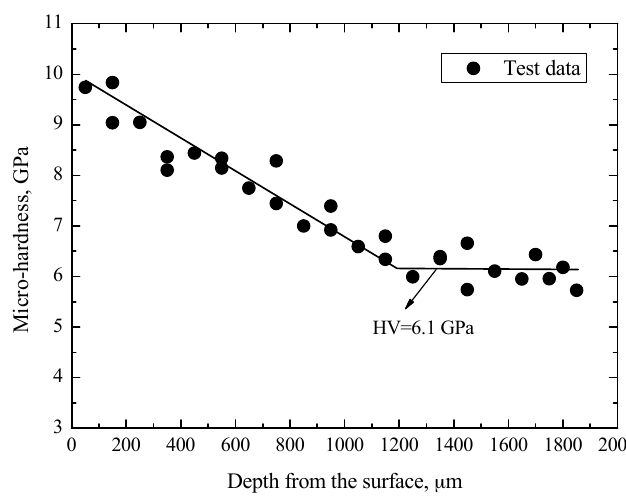
Figure 3. Distribution of micro-hardness.